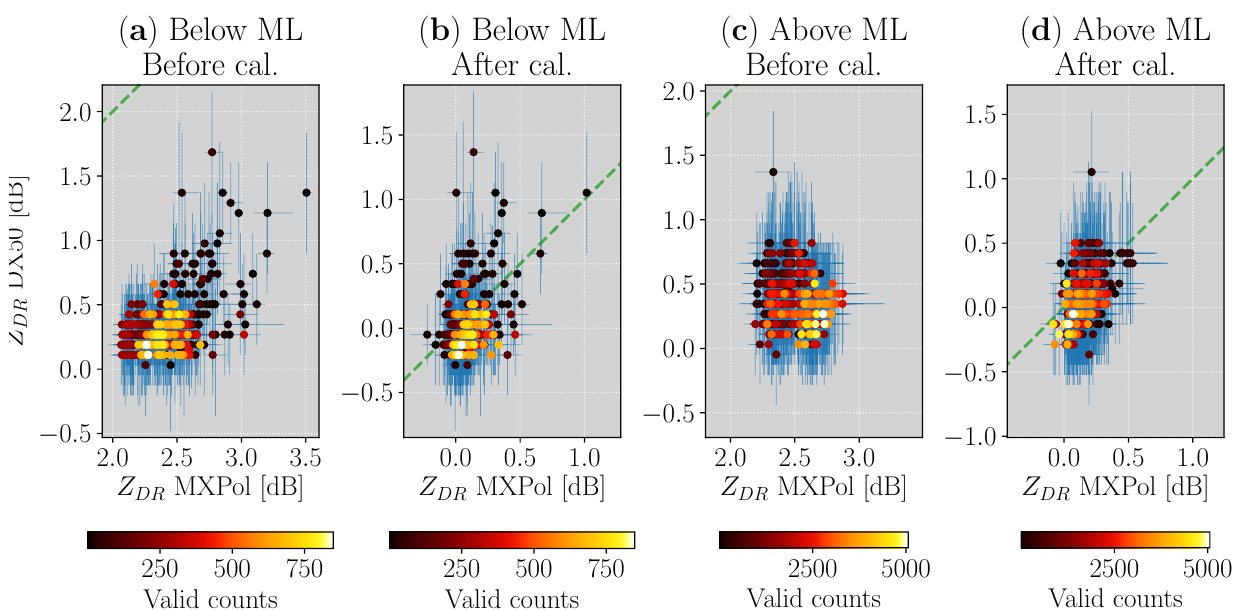
Figure A1. Comparison of overlapping Range Height Indicator (RHI) scans of the two radars for the PAYERNE campaign. ( a ) Scatterplot of the median uncalibrated Z DR values of MXPol against DX50, including only radar volumes below the melting layer. The blue lines represent the interquartile range of the distribution at each time step. The color associated with each point indicates the minimum number of measurements, among the two radars, recorded in the valid region of the RHI scan. ( b ) The plot is analogous to the first panel, with calibrated Z DR values as input. The green dashed line is the 1-1 line. In ( c , d ) we repeat the same comparison for the radar volumes above the melting layer.